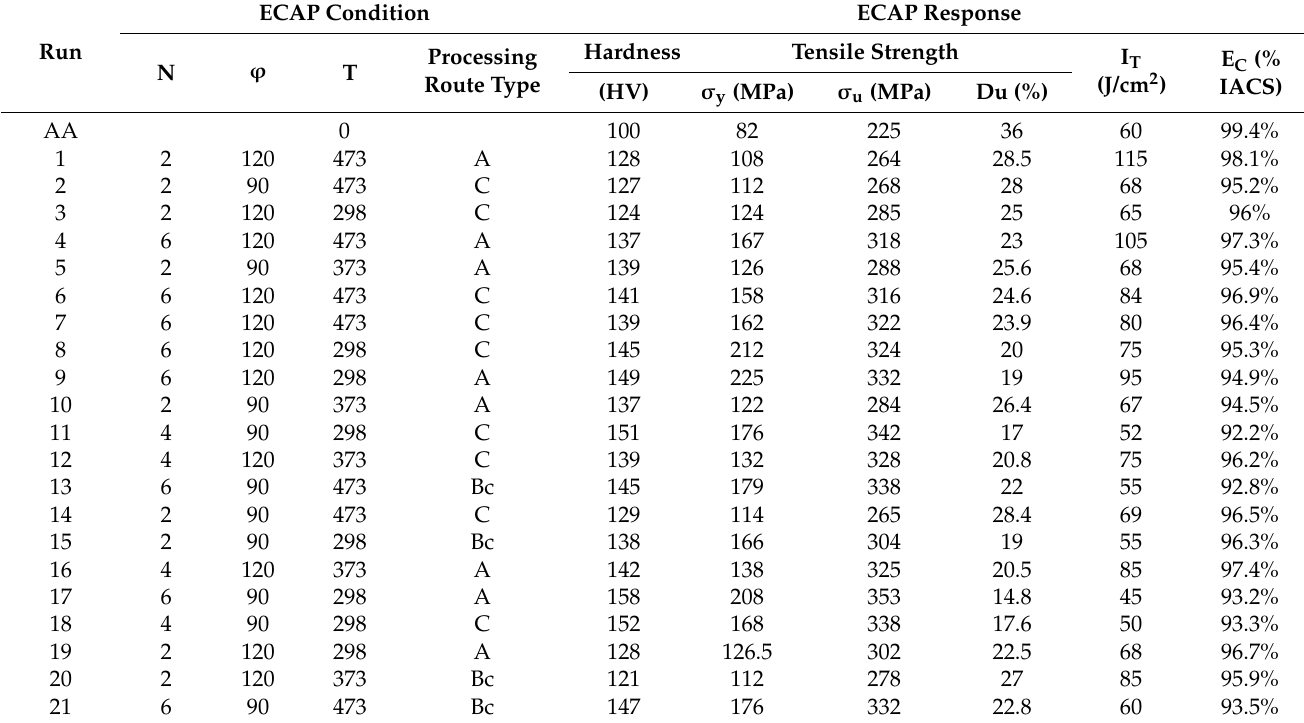
Table 2. Design of experiment of ECAP parameters and process